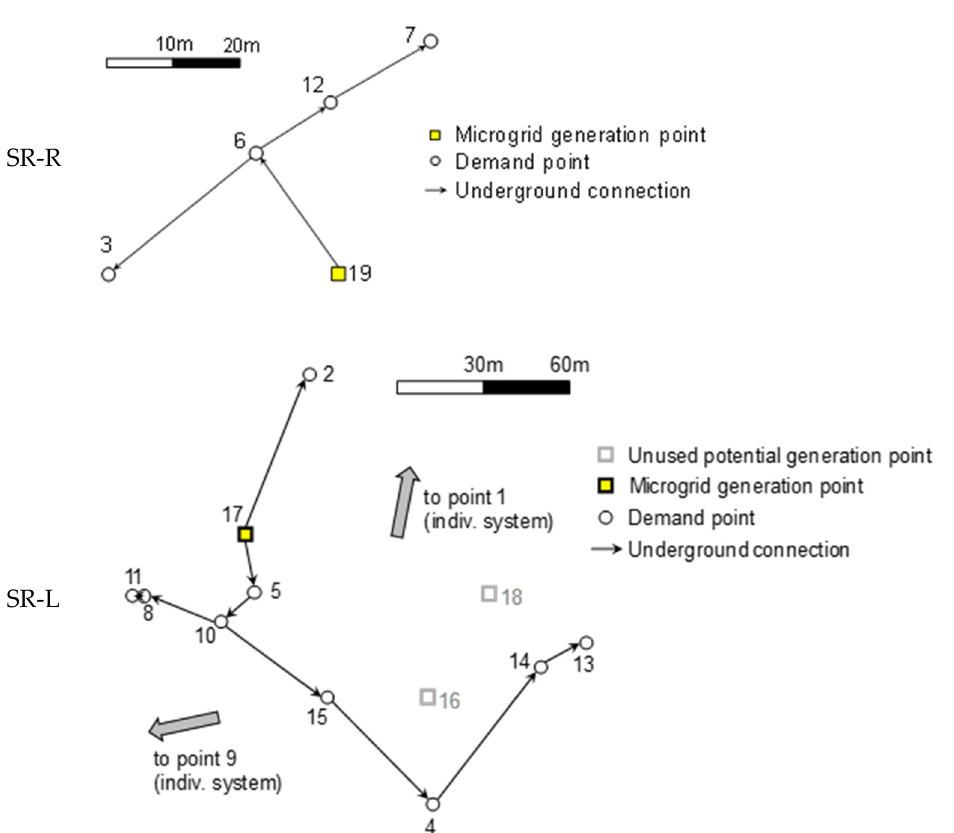
Figure 8. Microgrid obtained for Santa Rosa.